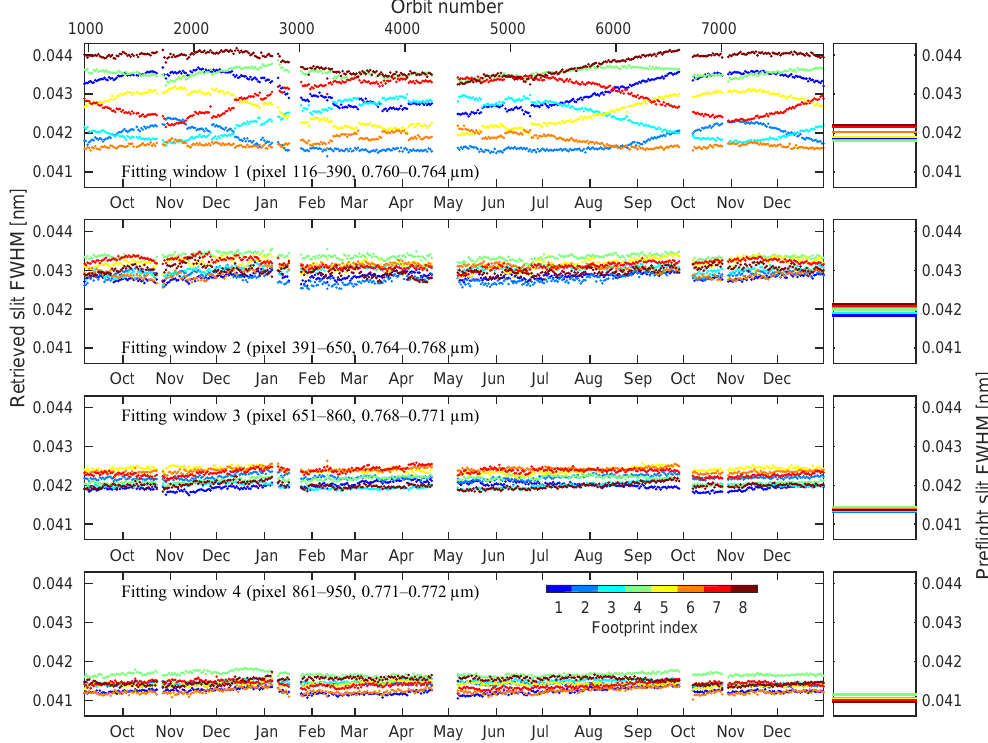
Figure 7. Left column: temporal variation of derived ILS FWHM using hybrid asymmetric Gaussian function in four fitting windows for all spatial footprints in the O2A band. Right column: average preflight ILS FWHM in those fitting